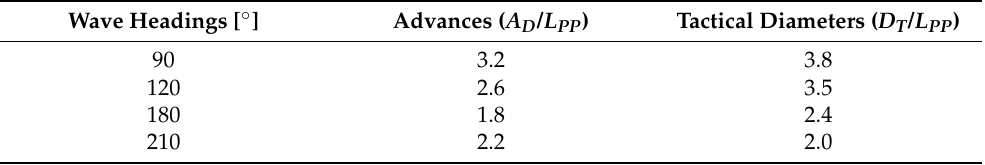
Table 4. The advances and the tactical diameters of ships at different wave headings.